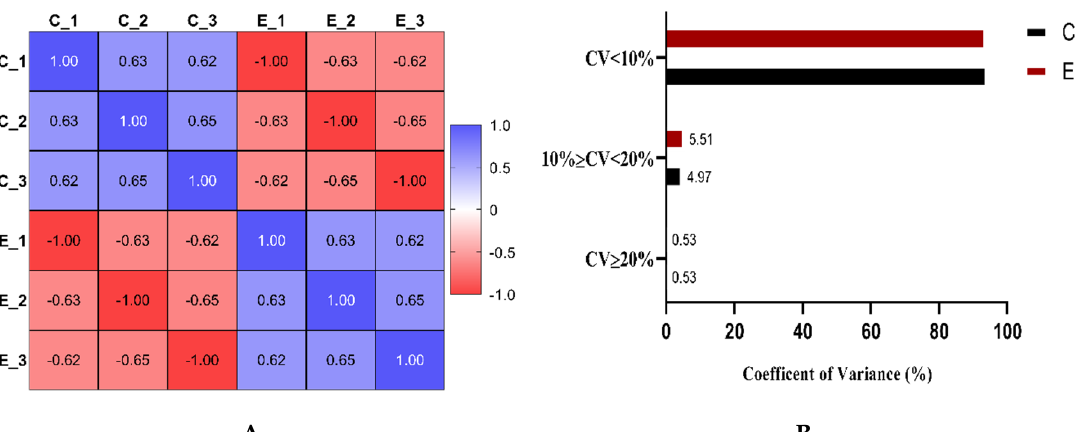
Figure 5. Precision of proteomic quantification. The stability of proteomics data was determined by estimating the Pearson’s correlation coefficient between the replicates of each group (C = 20% O 2 and E = 5% O 2 ). A significant correlation was found between the replicates of both groups ( A ). The reliability of the data was further supported by variance analysis, as more than 90% of the proteins from both groups had a coefficient of variance of less than 10% ( B ). For each replicate ( n = 3), 6 hatched blastocysts from each group ( n = 2) were included in proteomic analysis.